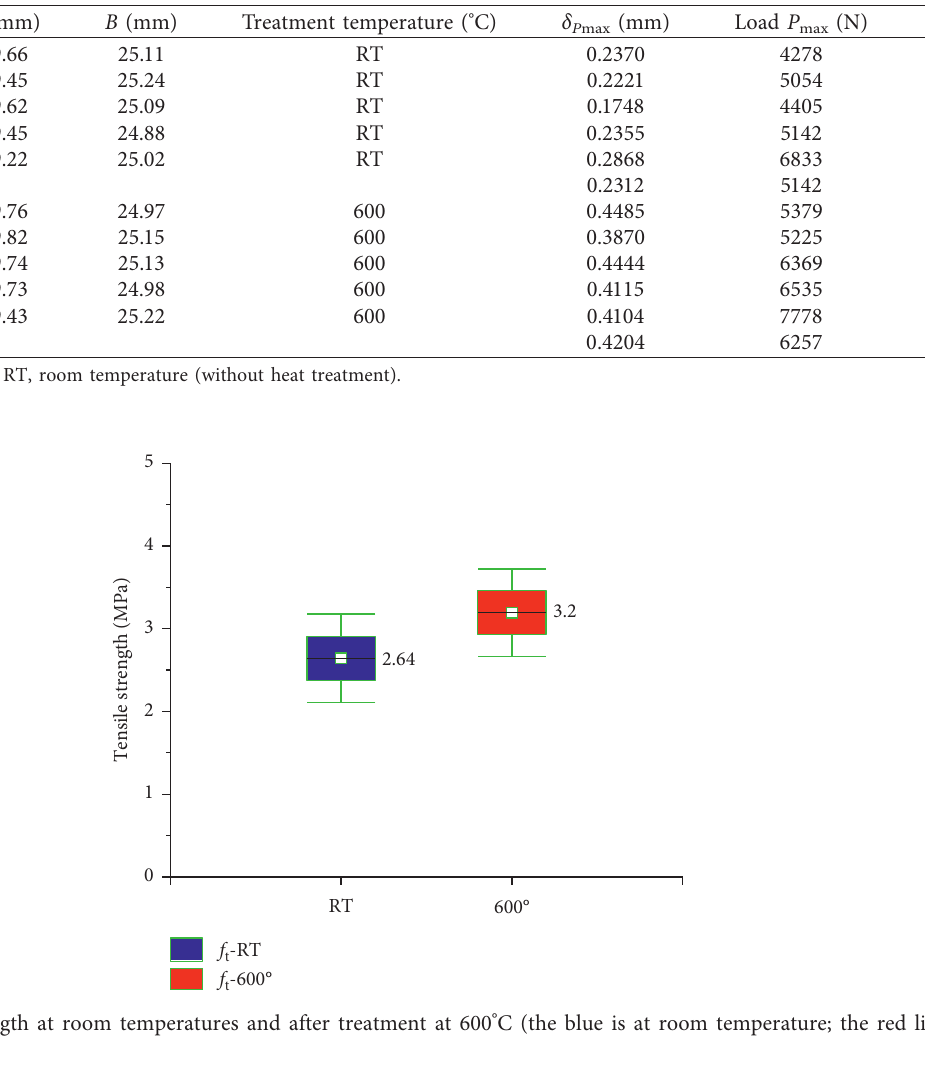
Table 4: Brazil split test results.